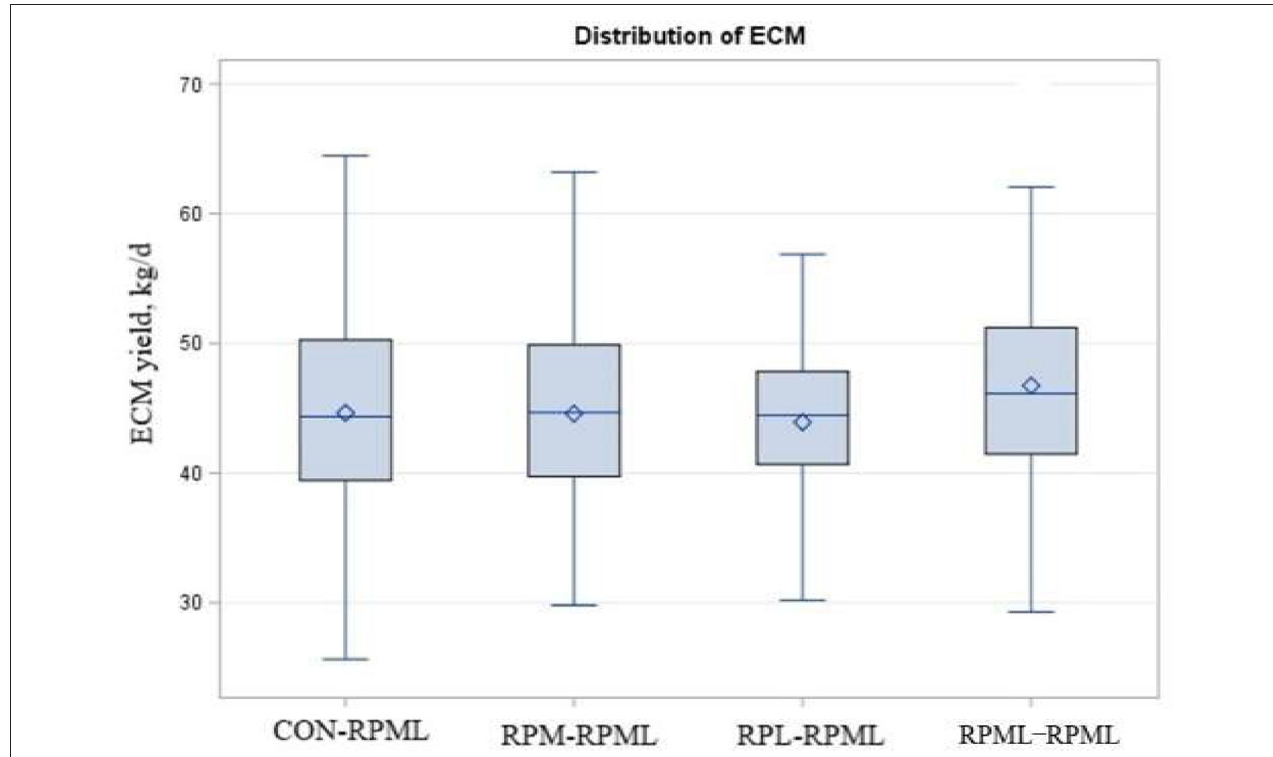
FIGURE 7 | Effect of supply ruminally protected Met and Lys to transition and milking dairy cows on ECM yield during the subsequent lactation. Values are means; standard errors are represented by vertical bars.